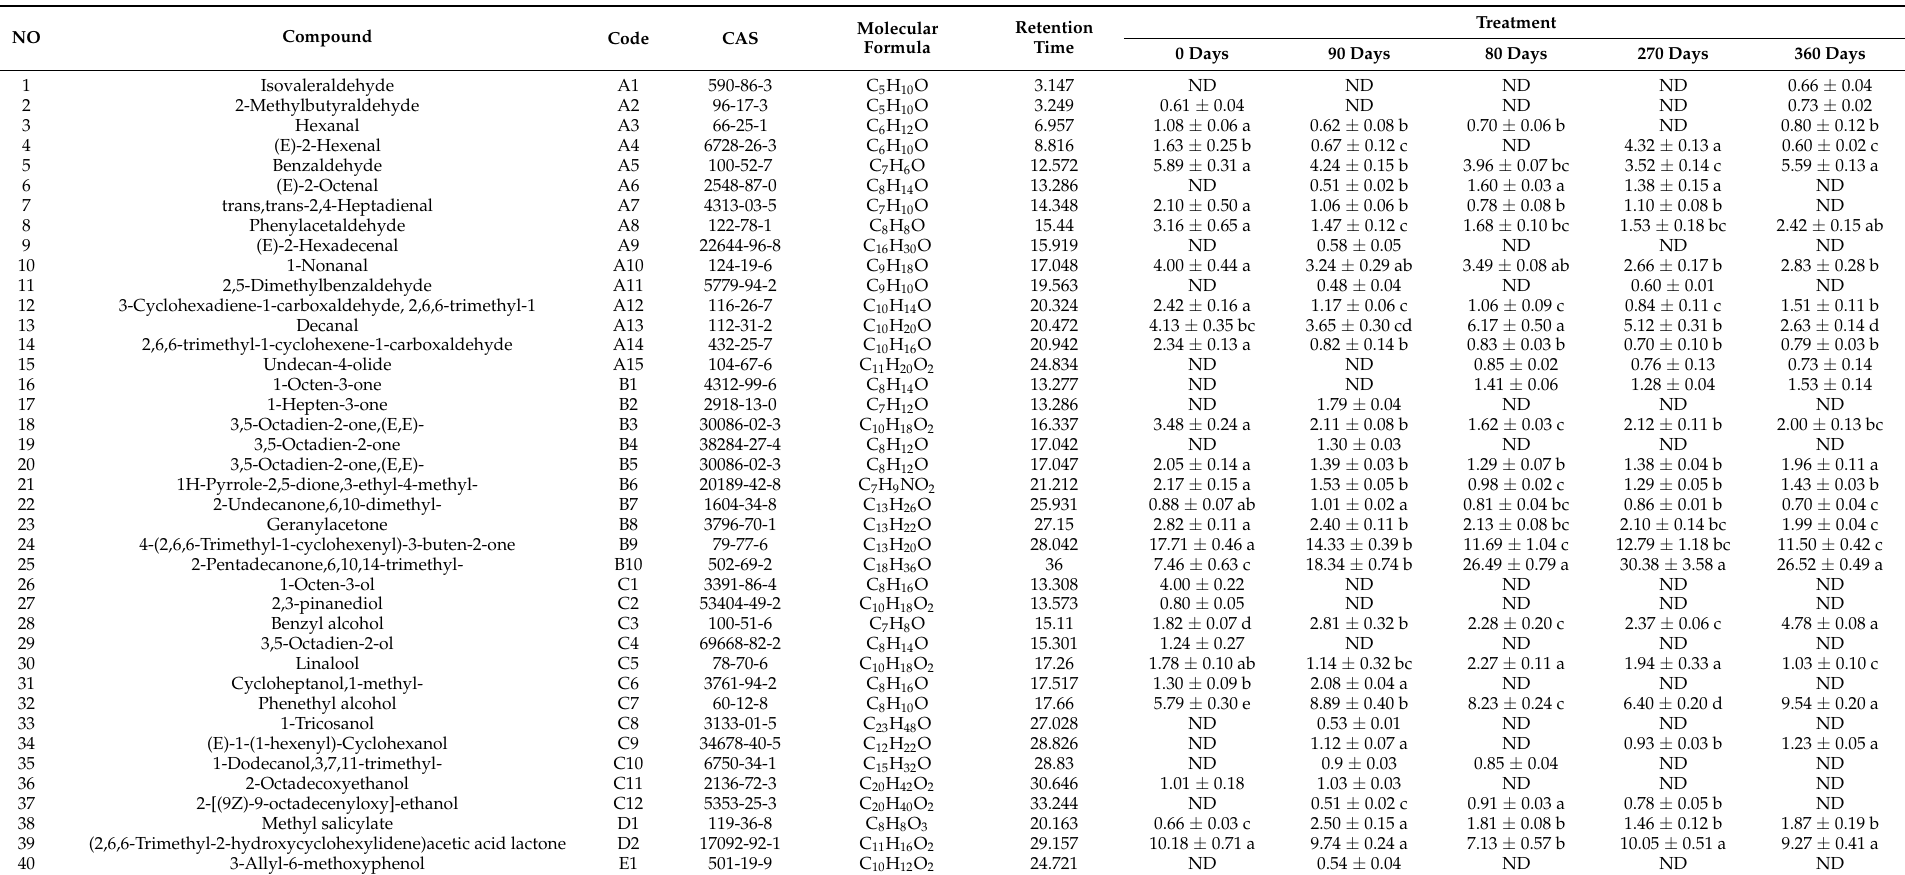
Table 3. Changes of VOCs in alfalfa during